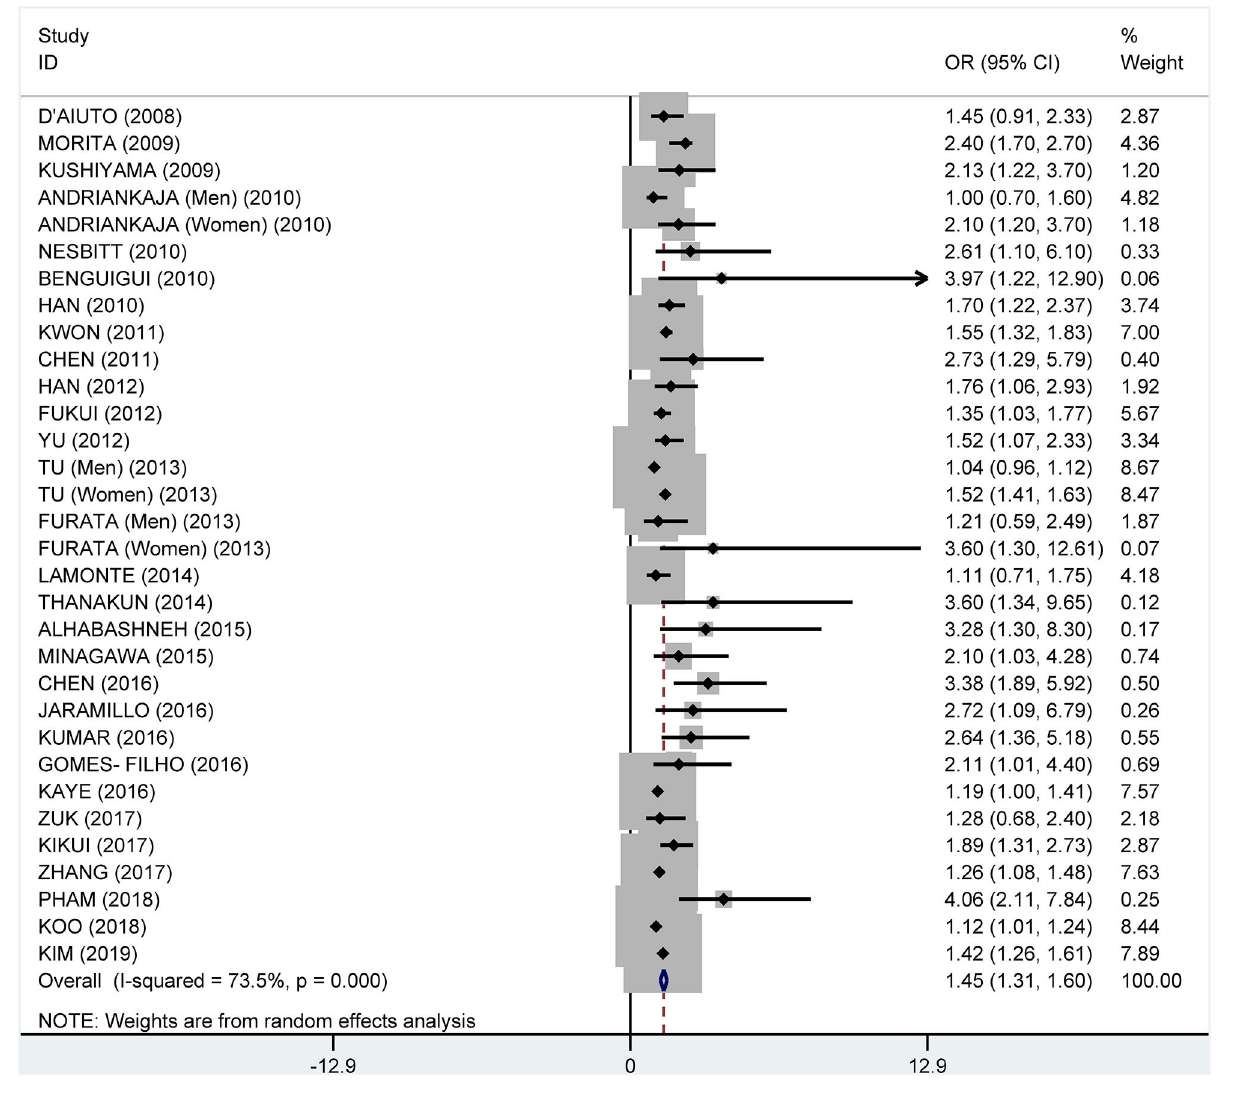
Frontiers in Endocrinology |